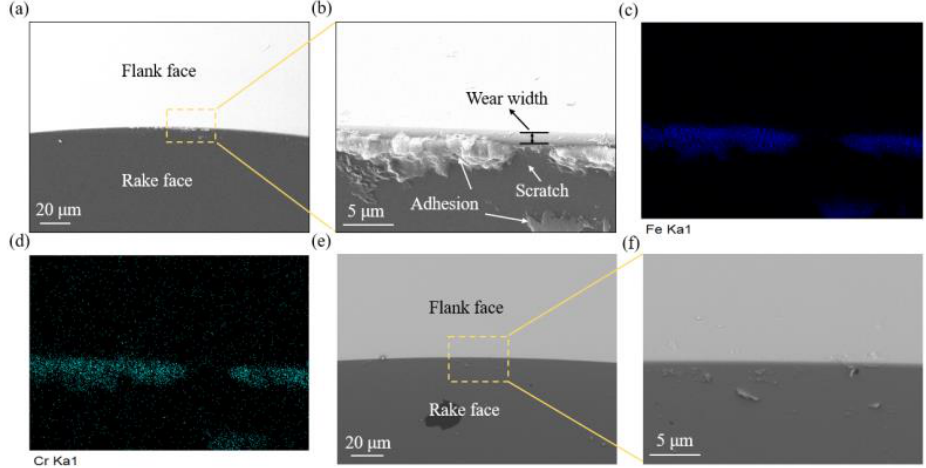
Figure 11. ( a , b ): SEM of the cutting tool after CS of the microlens array, ( c , d ): EDS analysis results of ( b , e , f ): SEM of the cutting tool after HFUVAS of the microlens array.